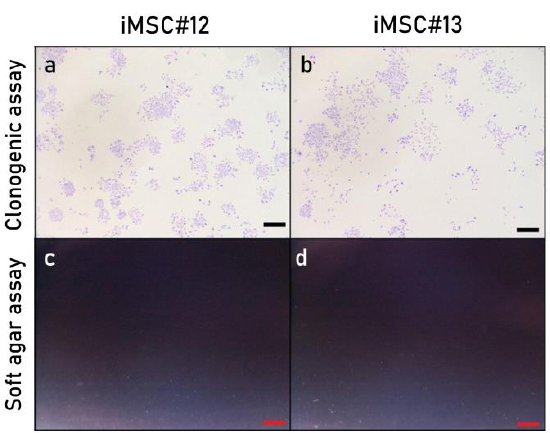
Figure 8. Crystal violet staining to assess the clonogenic potential of iMSC lines #12 ( a ) and #13 ( b ) and soft agar assay to assess their oncogenic potential ( c , d ). Scale bar: 1 mm.